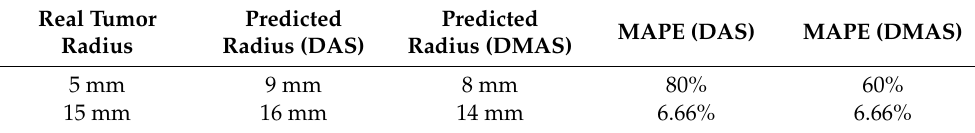
Table 5. MAPE of predicted tumor sizes from reconstructed images by DAS and